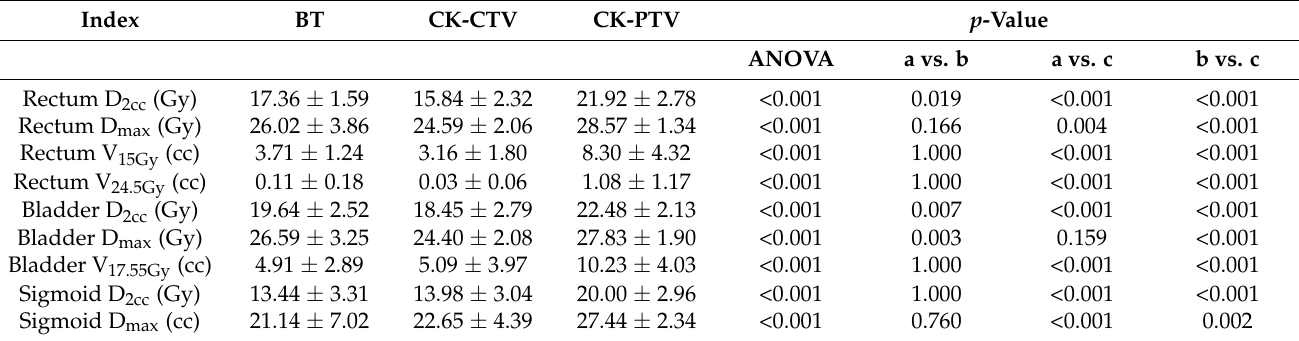
Table 3. Dose parameters comparison in relation to the OARs in the BT, CK-CTV and CK-PTV plans.